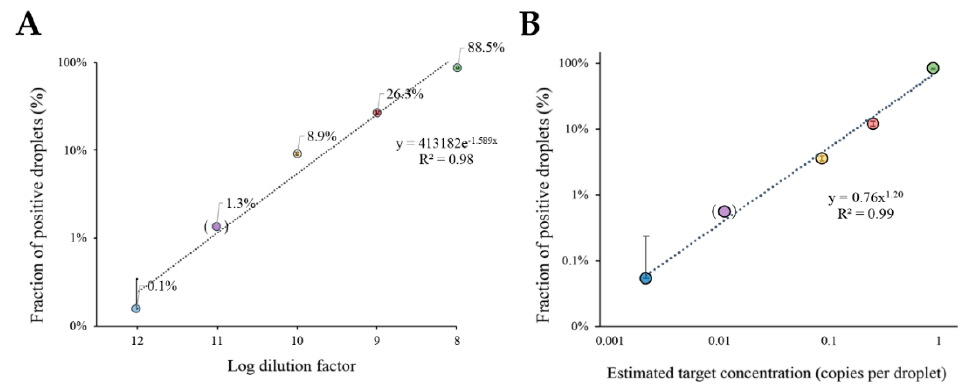
Figure 4. Target DNA quantification with ddLAMP. ( A ) Fraction of positive events attained with Poisson-based correction for different target dilutions. The fraction of positive events corrected to the Poisson statistics are represented in a logarithmic scale. The trendline presents an exponential equation: y = 413182e − 1.589X and a R 2 = 0.98. Data were obtained through the measurement of the area of the droplets and corresponding mean grey value with ImageJ software. ( B ) The plot of the positive droplet fraction against the expected DNA concentration in copies per droplet shows an exponential relationship predicted by Poisson distribution. The trendline for the power adjustment has a R 2 = 0.99 and an equation: y = 0.76x 1.20 . Copy number for each dilution was calculated with the equation C = − ln (1 – E pos ). For both panels: The error bars correspond to the standard deviation of two independent experiments (n = 2) with 400 measured droplets for each reaction; dilution factor 11 (between brackets) was only performed once (n = 1). ( • ) Represents the 10 − 12 dilution, ( • ) Represents the 10 − 11 dilution ( • ) Represents the 10 − 10 dilution, ( • ) Represents the 10 − 9 dilution, and ( • ) Represents the 10 − 8 dilution. A similar approach was then used for absolute quantification of c-MYC molecules in each